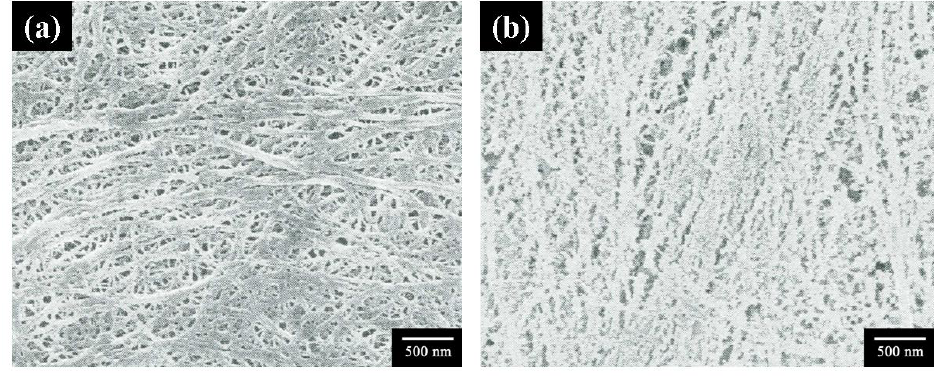
Figure 6. SEM micrographs of (a) PE and (b) the modified PE membranes. Reproduced with permission from Reference [58]. © 2009 Elsevier Ltd.